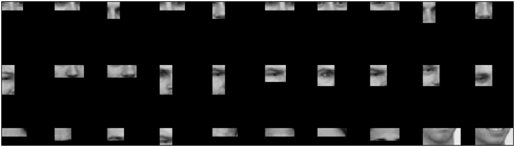
Face fragments with high (top), intermediate (middle) or low (bottom) levels of detection-specific information.